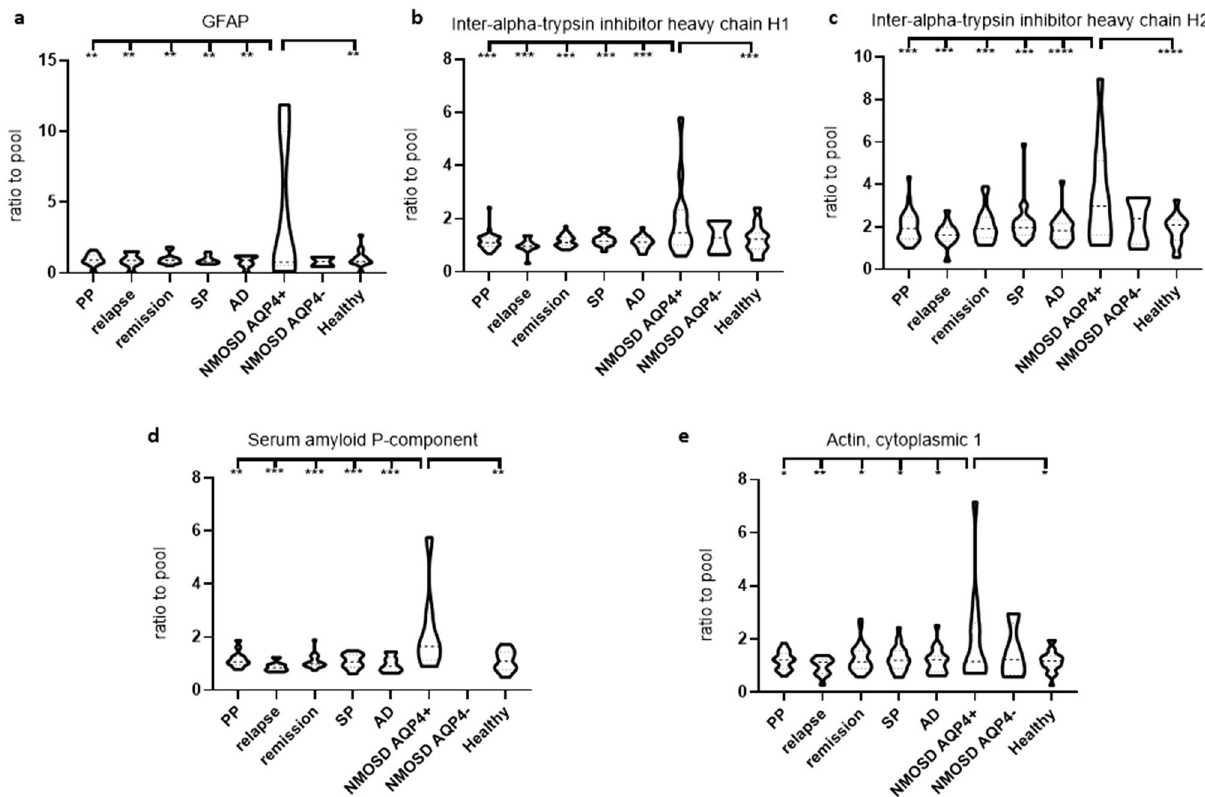
Figure 6. Significantly upregulated unique molecular markers in the CSF of AQP4-IgG + NMOSD. Five proteins were uniquely upregulated in the CSF of patients with AQP4-IgG + NMOSD compared to OND and healthy controls. ( a ) Glial fibrillary acidic protein (GFAP) (detection: PP = 12 of 30; relapse = 8 of 14; remission = 13 of 33; SP = 10 of 26; AD = 8 of 22; NMOSD AQP4-IgG + = 9 of 13; NMOSD AQP4-IgG − = 2 of 5; healthy = 23 of 27). ( b ) Inter-alpha-trypsin inhibitor heavy chain H1 (detection: PP = 30 of 30; relapse = 14 of 14; remission = 33 of 33; SP = 26 of 26; AD = 22 of 22; NMOSD AQP4-IgG + = 13 of 13; NMOSD AQP4-IgG − = 5 of 5; healthy = 27 of 27). ( c ) Inter-alpha-trypsin inhibitor heavy chain H2 (detection: PP = 30 of 30; relapse = 14 of 14; remission = 33 of 33; SP = 26 of 26; AD = 22 of 22; NMOSD AQP4-IgG + = 13 of 13; NMOSD AQP4-IgG − = 5 of 5; healthy = 27 of 27). ( d ) Serum amyloid P-component (detection: PP = 13 of 30; relapse = 7 of 14; remission = 16 of 33; SP = 14 of 26; AD = 10 of 22; NMOSD AQP4-IgG + = 7 of 13; NMOSD AQP4-IgG − = 1 of 5; healthy = 12 of 27). ( e ) Actin, cytoplasmic 1 (detection: PP = 26 of 30; relapse = 13 of 14; remission = 30 of 33; SP = 23 of 26; AD = 19 of 22; NMOSD AQP4-IgG + = 12 of 13; NMOSD AQP4-IgG − = 4 of 5; healthy = 23 of 27). CSF cerebrospinal fluid, NMOSD AQP4‑IgG +/− neuromyelitis optica spectrum disorder positive for aquaporin-4 antibody, AD Alzheimer